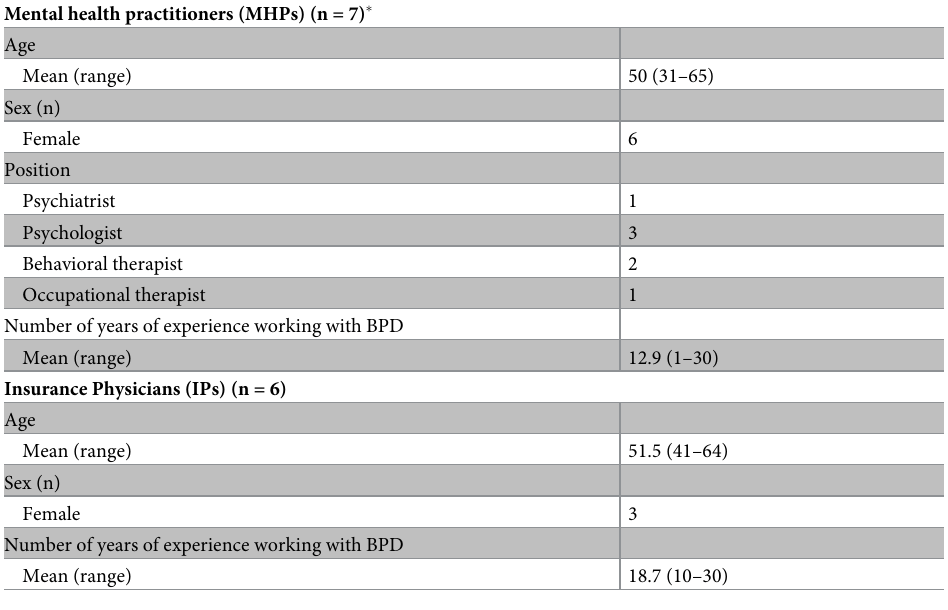
Table 2. Characteristics of mental health practitioners and insurance